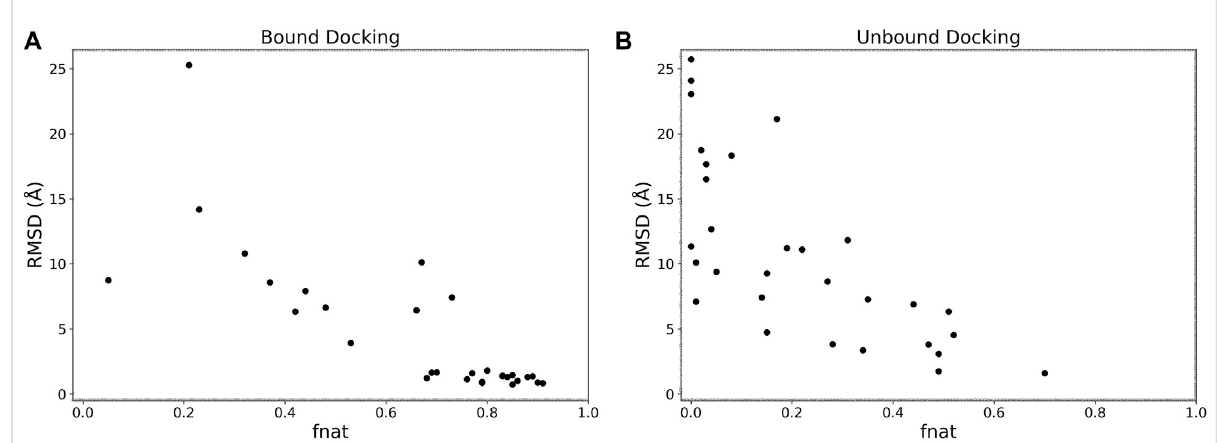
FIGURE 5 RMSD vs. fnat. The best RMSD (Å) among the top 5 scored models relative to its fnat. (A) , the bound docking experiment; (B) , the unbound docking